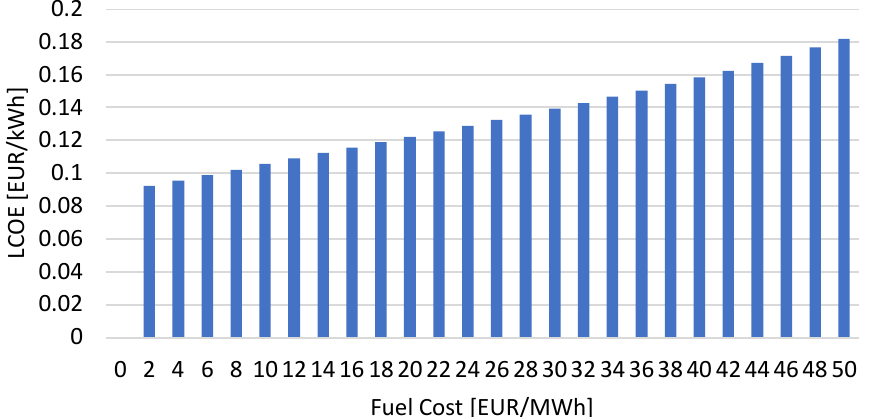
Figure 11. Fuel cost influence on the Levelized Cost of Electricity.